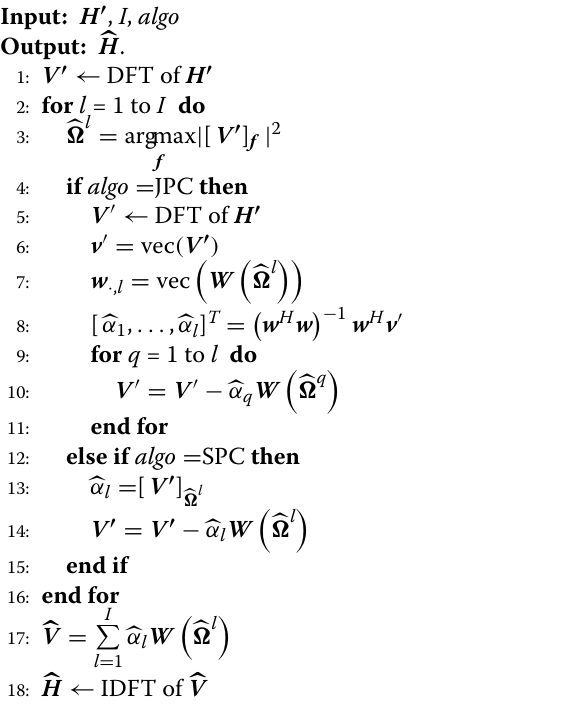
Algorithm 1 SPC and JPC channel estimation